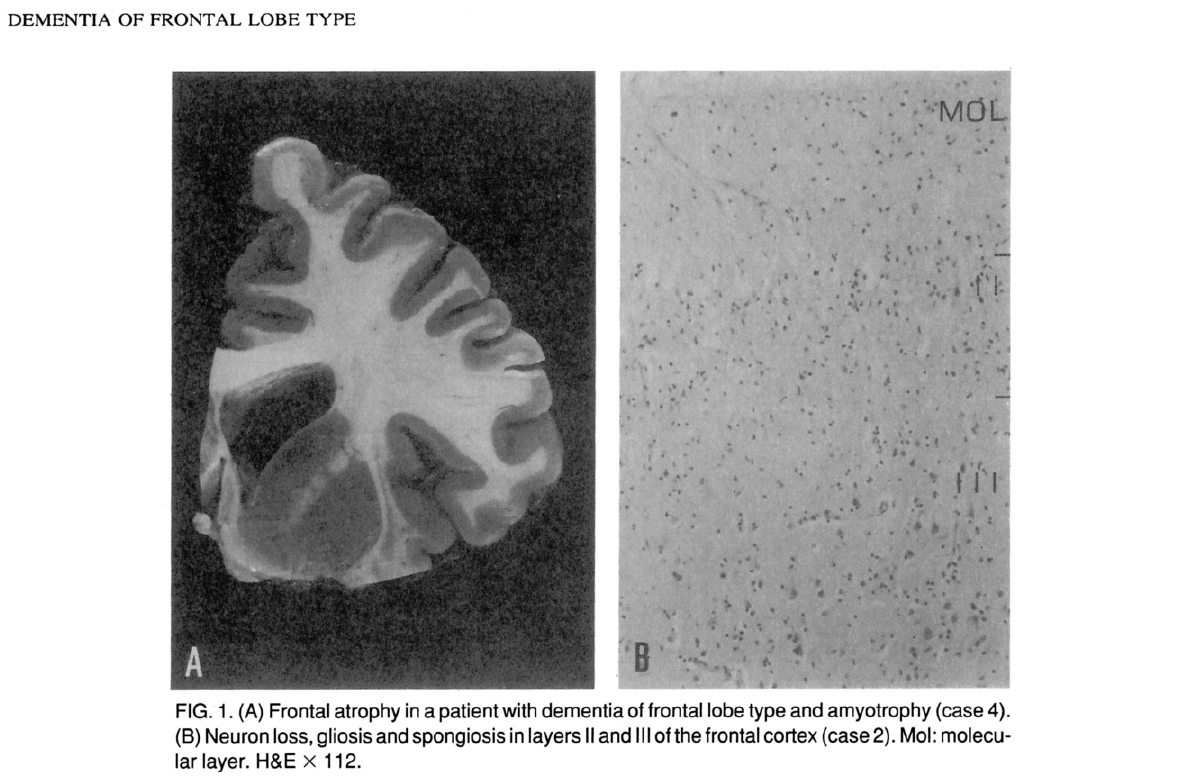
FIG. 1. (A) Frontal atrophy in a patient with dementia of frontal lobe type and amyotrophy (case 4). (8) Neuron loss, gliosis and spongiosis in layers II and III of the frontal cortex (case 2). Mol: molecu lar layer. H&E x